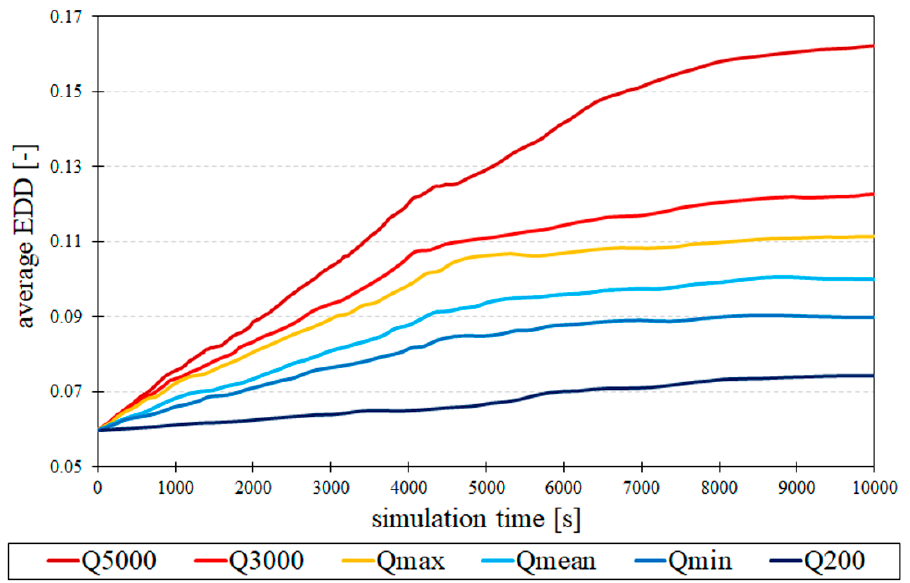
Figure 5. Averaged Eco-Environmental Diversity index along the reach.